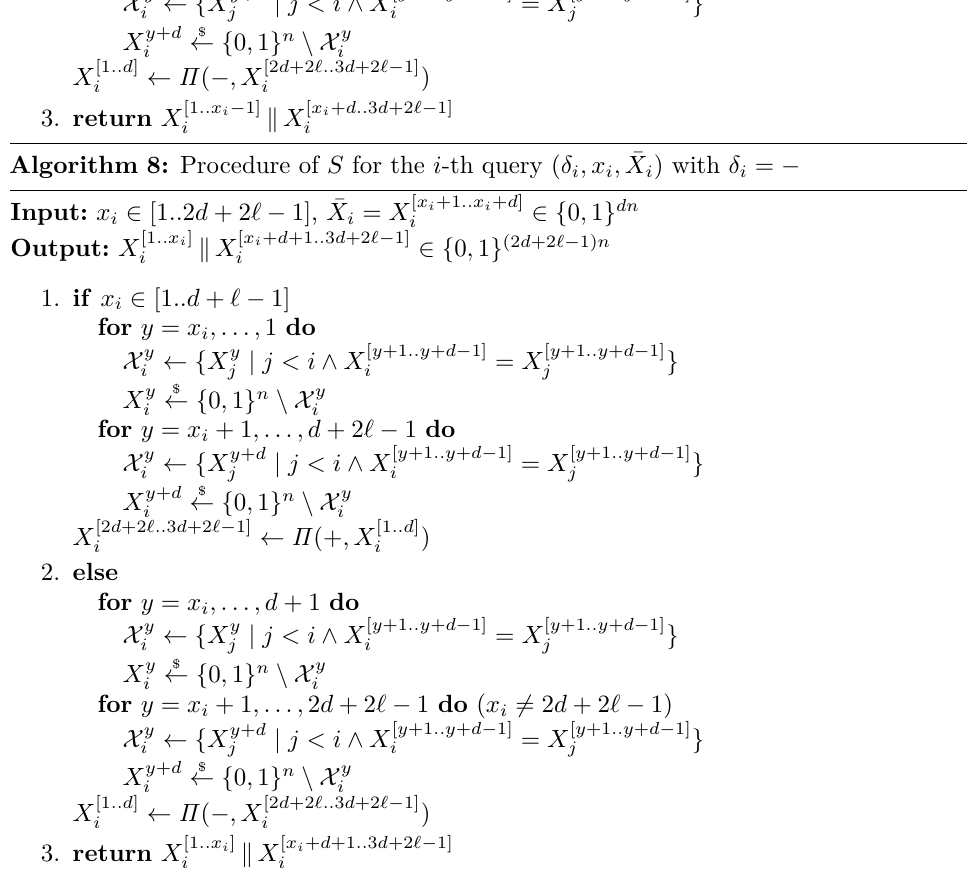
Figure 8: Procedure of S . See the main body for the explanation. Note that line 1 in both Algorithms 7 and 8 handles upper queries, and they are essentially the same. Similarly, line 2 in both Algorithms 7 and 8 handles lower